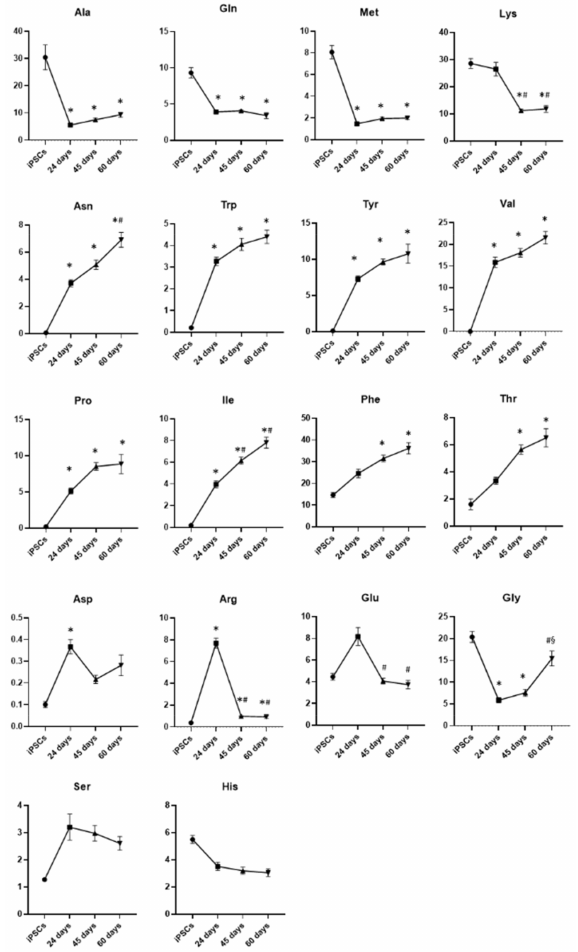
Figure 10. Graphic representation of the major changes related to amino acids in iPSCs and DA neurons at days 24, 45 and 60 of differentiation. Data represent mean ± SEM from at least triplicates of cultures from iPSCs and DA neurons at days 24, 45 and 60 of differentiation: Ala, alanine; gln, glutamine; met, methionine; lys, lysine; asn, asparagine; trp, tryptophan; tyr, tyrosine; val, valine; pro, proline; ile, isoleucine; phe, pheylalanine; thr, threonine; asp, aspartate; arg, arginine; glu, glutamate; gly, glycine; ser, serine; his, histidine. * Significant v. iPSCs, # significant v. 24 days, § significant v. 45